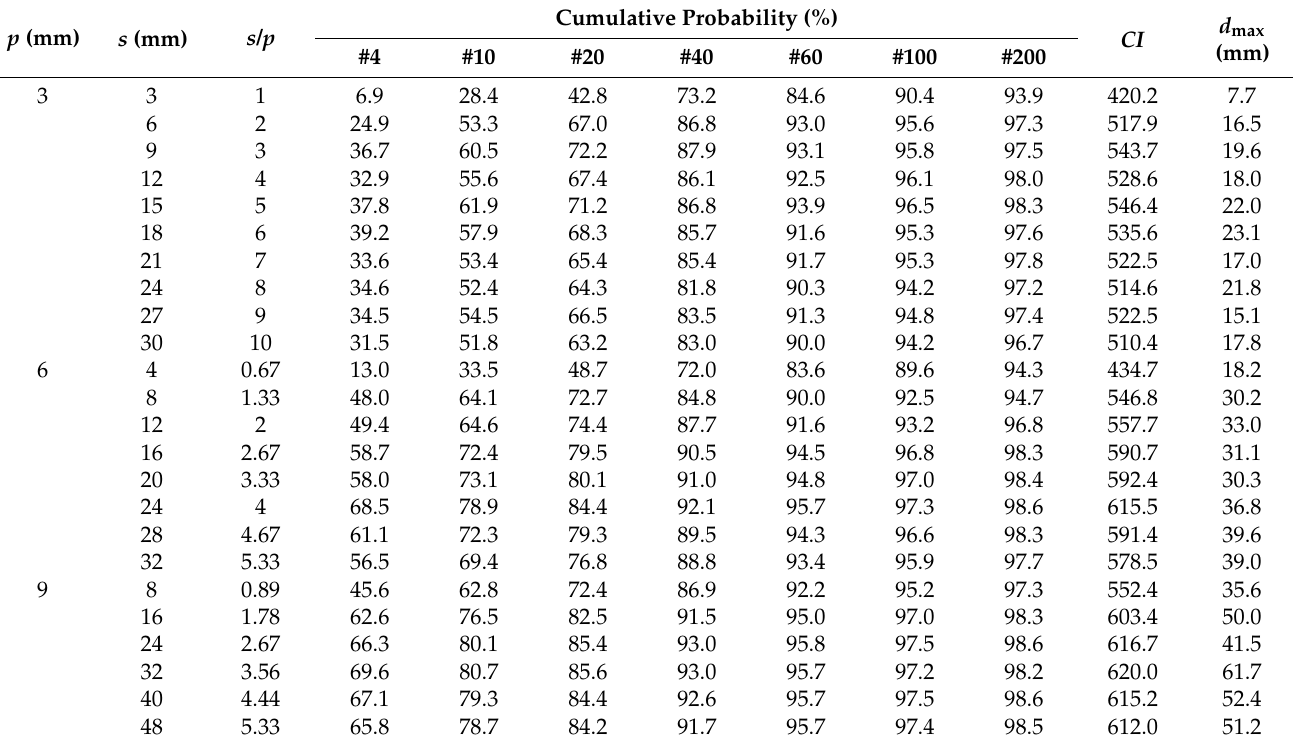
Table 5. Chip size distribution and maximum diameter for model rock of UCS 40